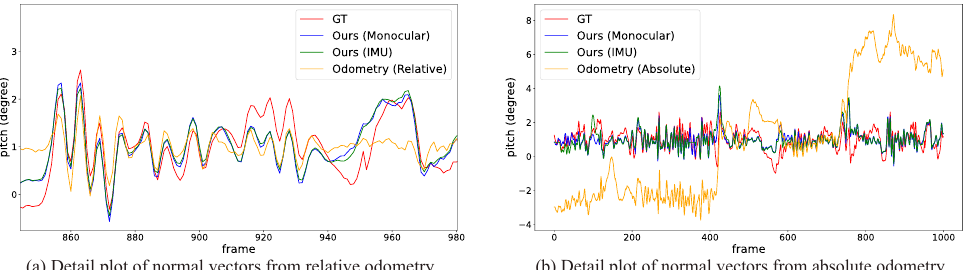
Figure 11. Comparing ground plane normal estimated by odometry